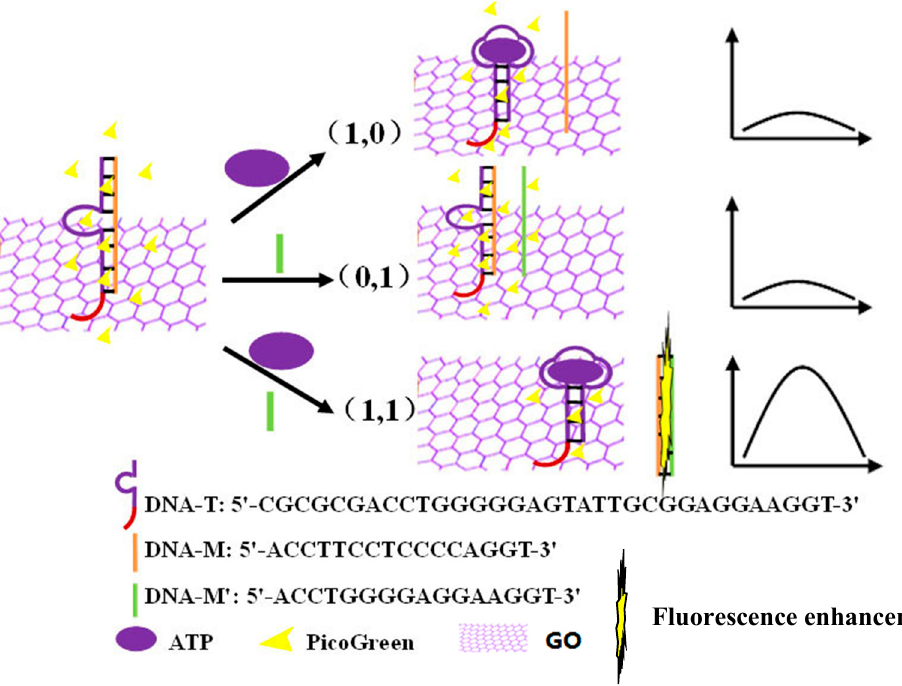
Figure 1. The principle of AND logic gate construction.